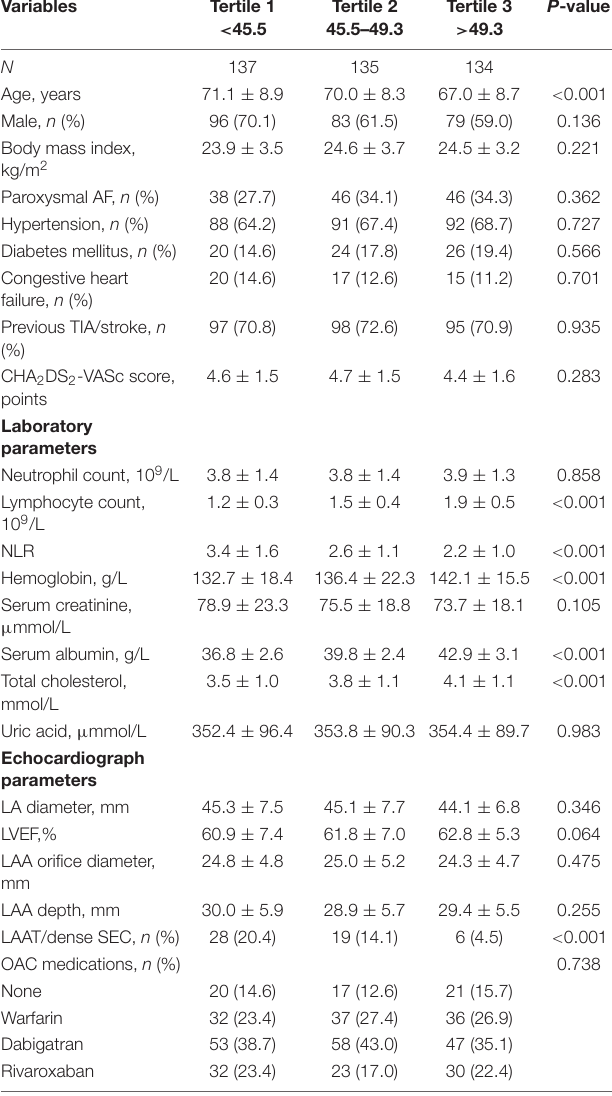
TABLE 1 | Baseline characteristics of the study population according to